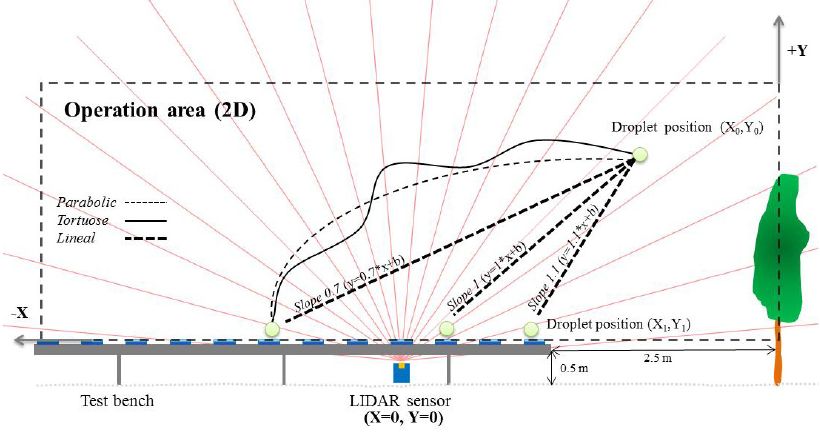
Figure 5. Representation of different droplet’s trajectory applied to predict final deposit over the test bench. In this case the linear trajectory with slope value=1 was chosen to model the droplet’s